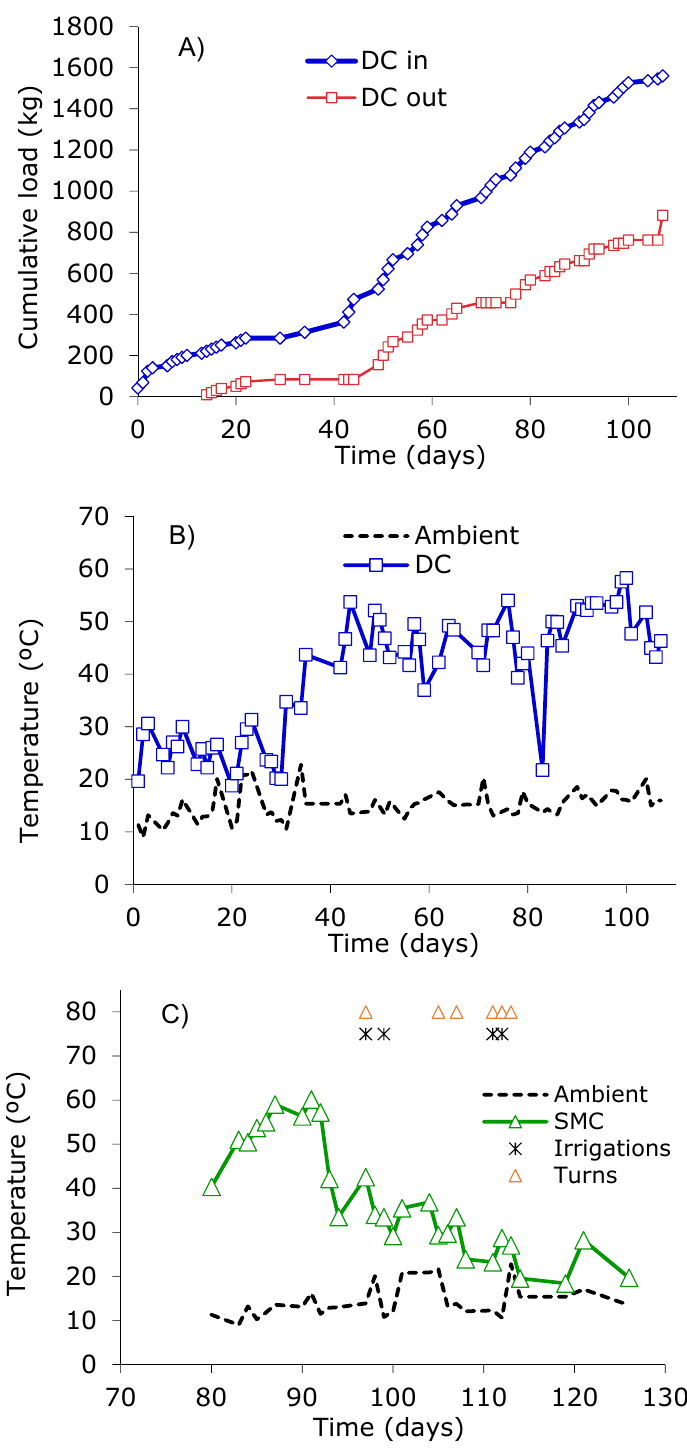
Figure 4. Operation of the dynamic composter (DC) and the static maturity composter (SMC) in the School of Architecture: ( A ) Evolution of the load and discharge applied to the DC, ( B ) Temperature evolution in the DC, ( C ) Temperature evolution in the SMC. For SMC, only one unit is shown, which is the one that received the output material from DC between days 78 and 92 of its operation (Figures A,B). The behavior of other batches was similar.